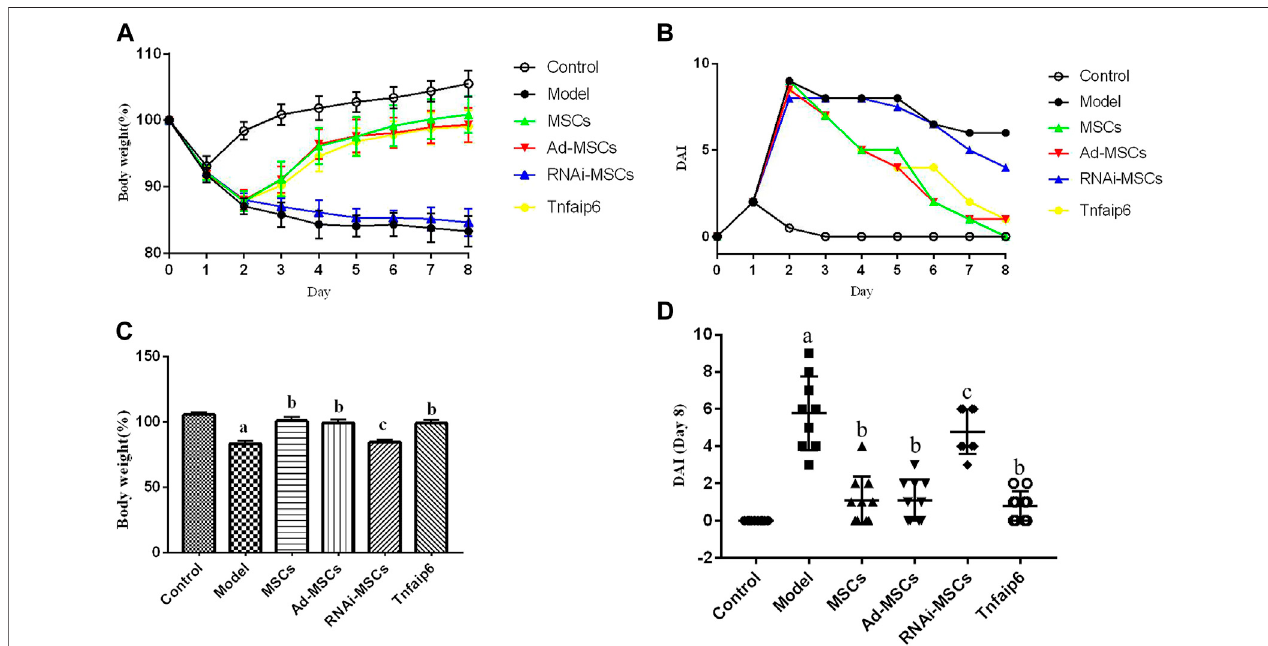
FIGURE 5 | Intraperitoneal injection of MSCs or Tnfaip6 ameliorates TNBS-induced colitis in mice. (A) Changes in body weight; (B) changes of the DAI; (C) comparisons of body weight on day 8; and (D) comparisons of the disease activity index on day 8. a p < 0.05 compared to the control group. b p < 0.05 compared to the model group. c p > 0.05 compared to the model group. n ≥ 9 per